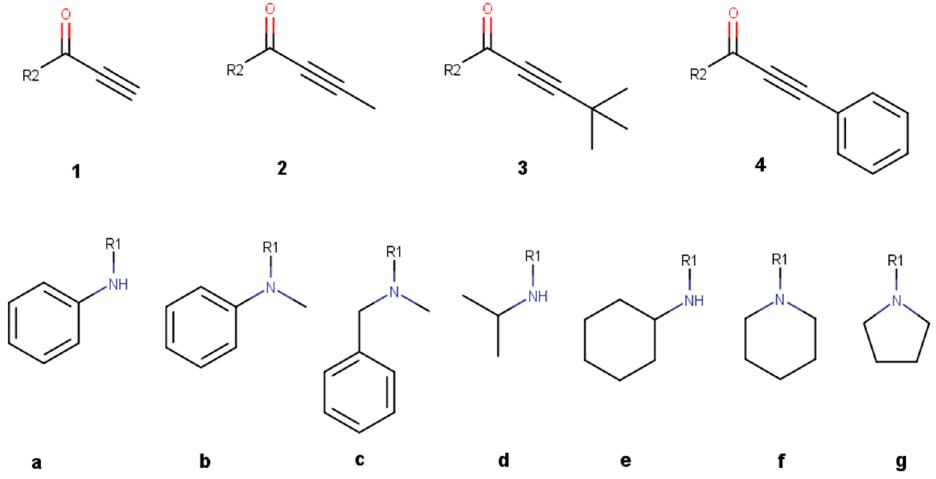
Figure 3. Benchmark molecules used for reactivity prediction of propynamide variations. The variations are divided into a right-hand side with different warheads ( 1 – 4 ) and a left-hand side with different non ‐ covalent scaffolds ( a – g ).